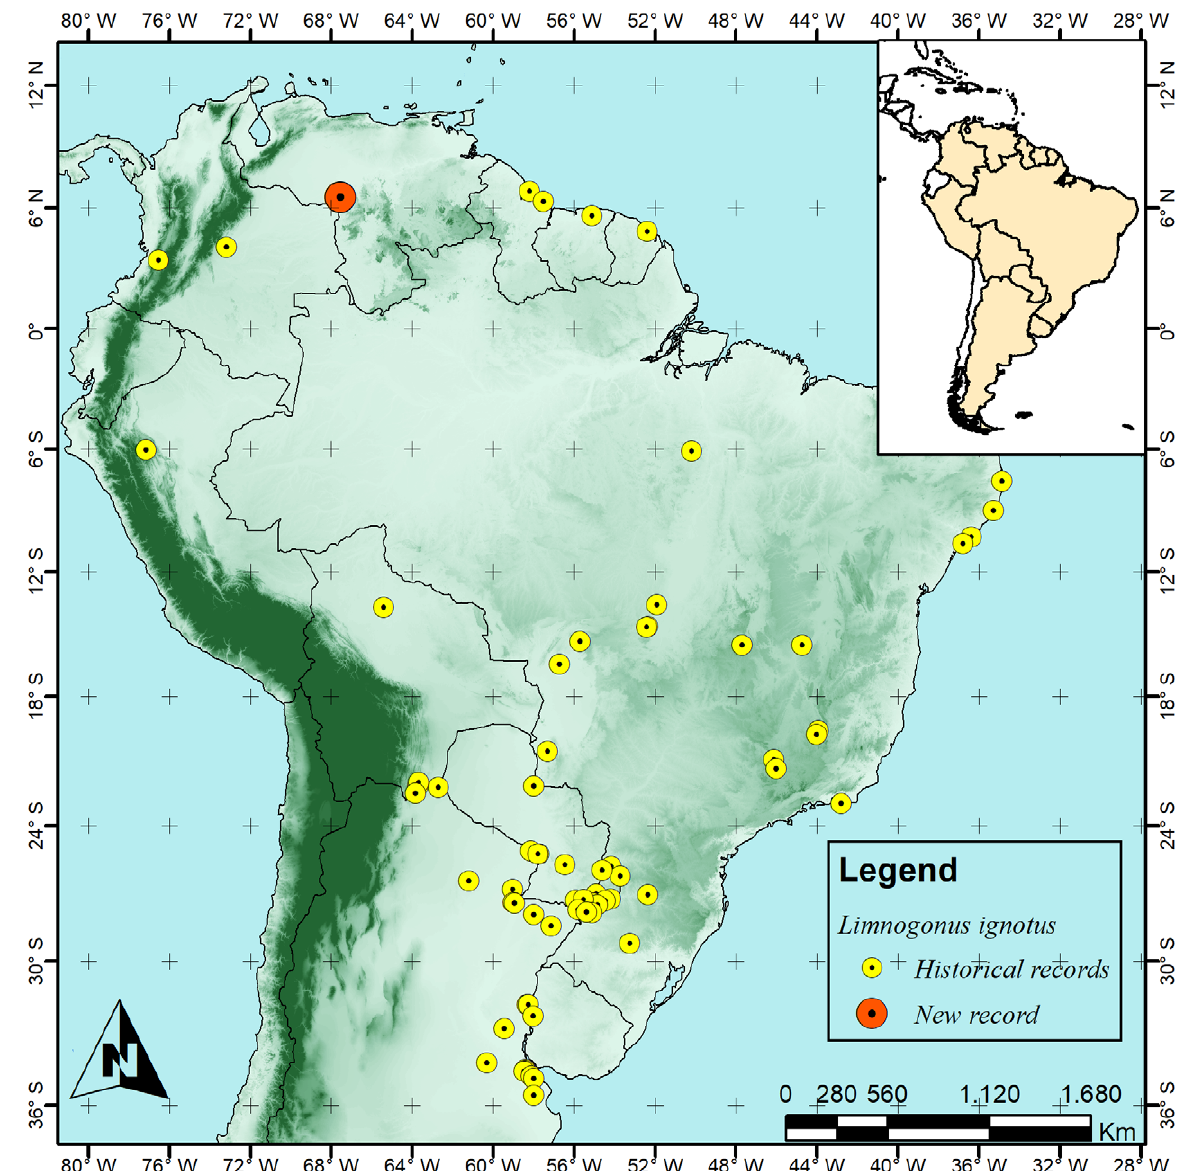
Figure 4. Historical and new records of Limnogonus ignotus in the